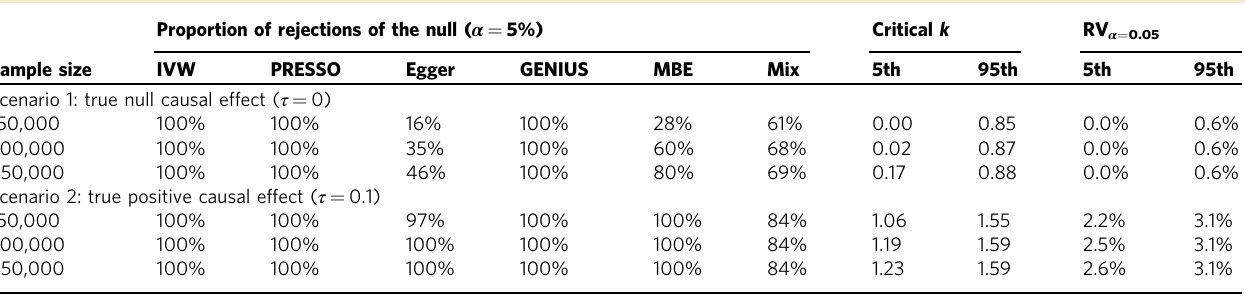
Table 3 Simulation of weak pleiotropic pathways violating the InSIDE assumption.